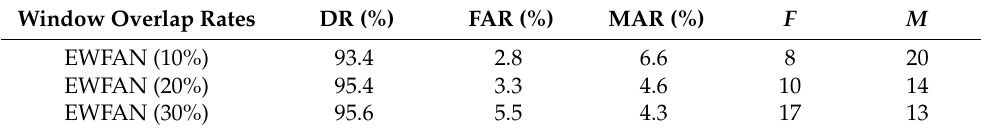
Table 3. Comparison of aircraft detection results with different window overlap rates.